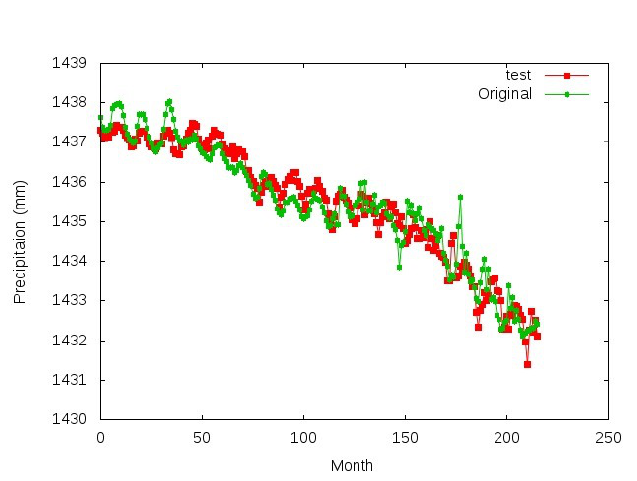
Fig. 7: Training under 200 hidden units and x 2 + x function